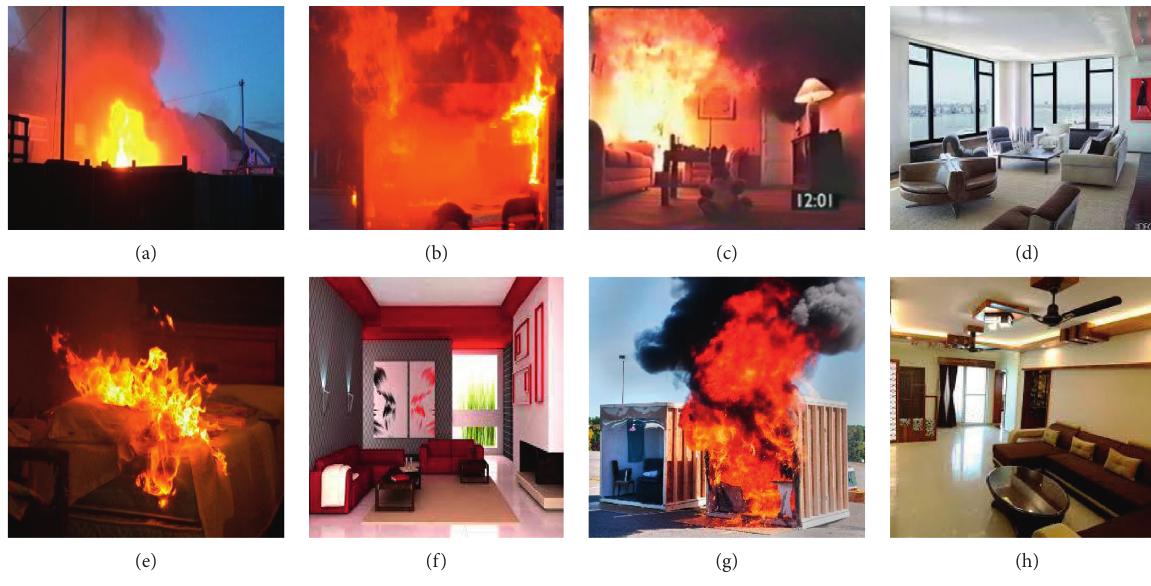
Figure 13: Sample images for